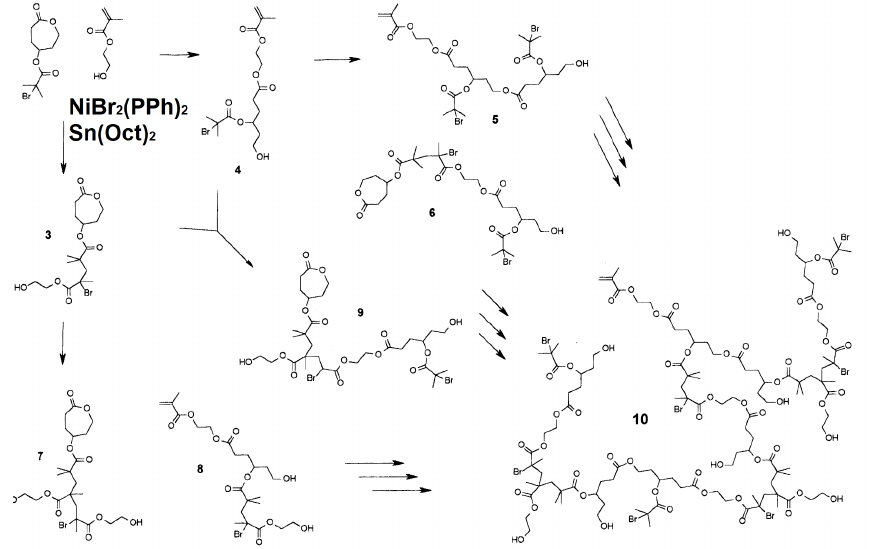
Figure 3. Concurrent atom transfer radical polymerization (ATRP) and ring-opening polymerization (ROP) for branched copolymer synthesis. Adapted with permission from [48], Copyright© 1999 American Chemical